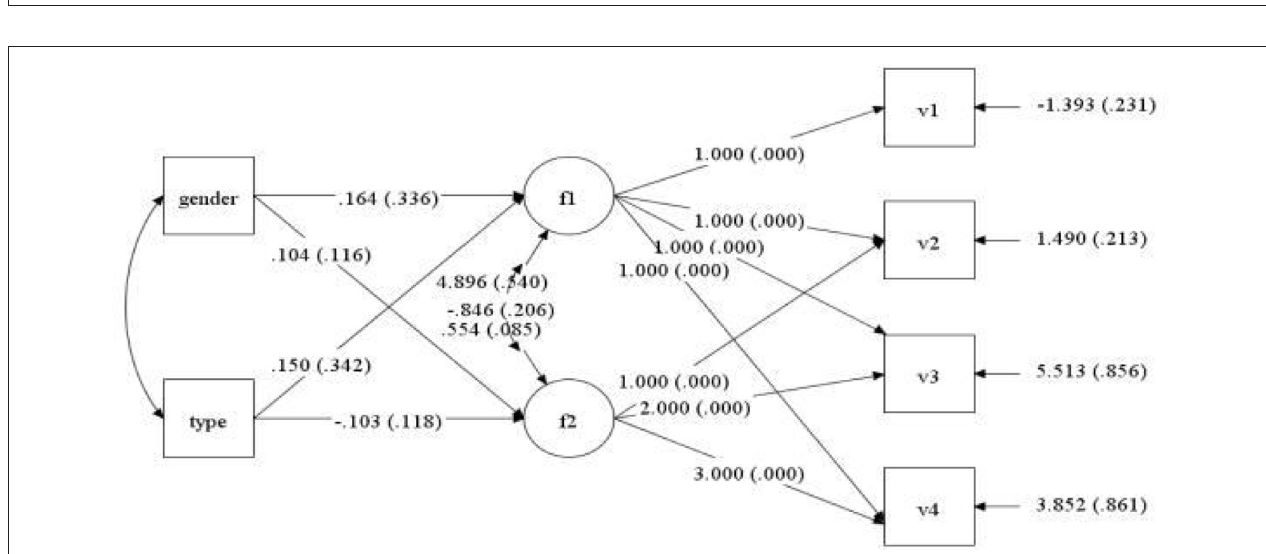
FIGURE 8 | The changing trajectory of depression of medical staff.